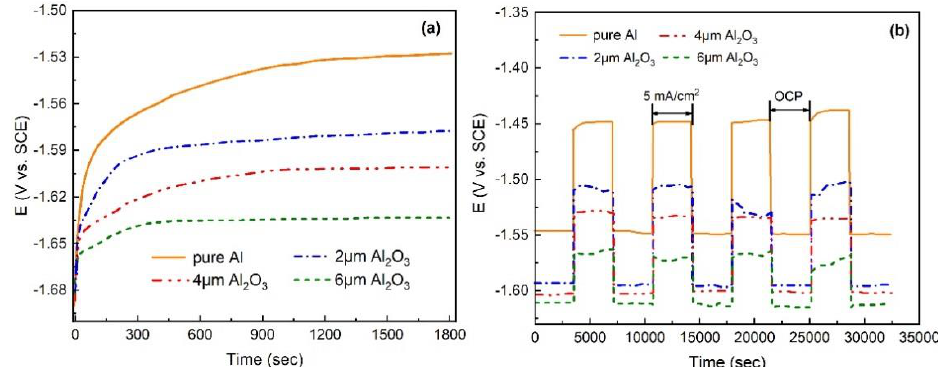
Figure 3. ( a ) Open-circuit potential (OCP) curves of Al anodes without and with different thicknesses of Al 2 O 3 films in 4 M KOH. ( b ) Potential-time transients recorded for Al anodes without and with different thicknesses of Al 2 O 3 films during 4 cycles (consisting of 1 h rest period at OCP and 1 h discharge at a current density of 5 mA/cm 2 ) in 4 M KOH.